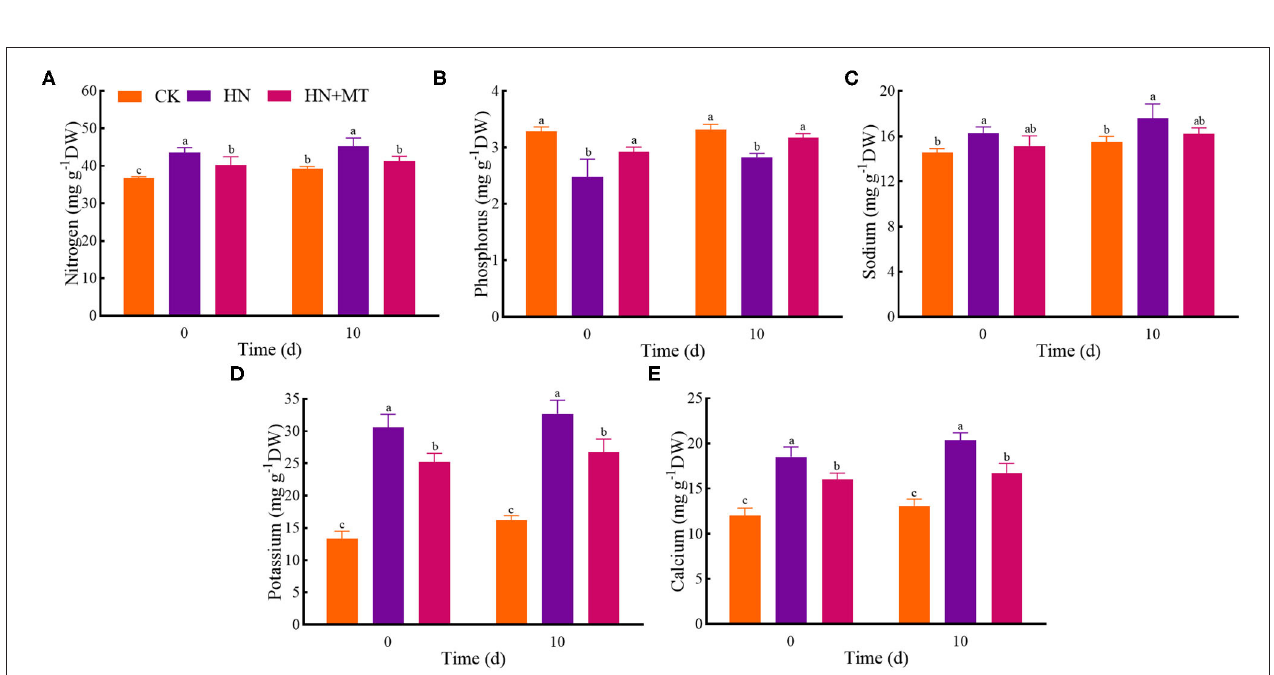
FIGURE 2 | Changes of nitrogen (A) , phosphorus (B) , sodium (C) , potassium (D) , and calcium (E) . The groups on the same day followed with the same letter are not significantly different at p < 0.05. Bars indicate the SDs of the means.